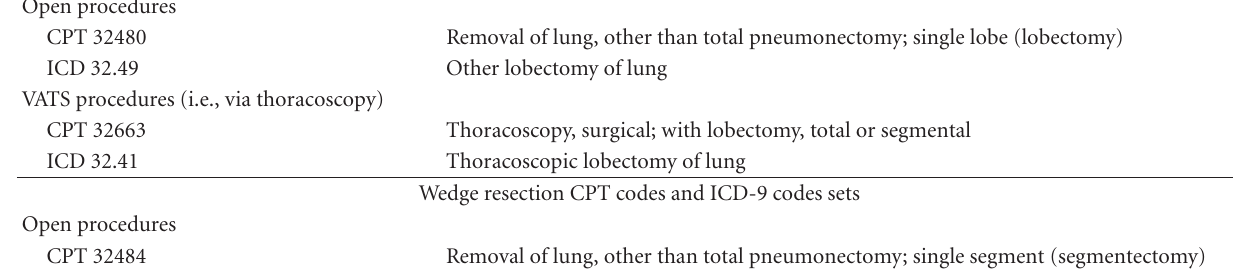
Pulmonary lobectomy CPT codes and ICD-9 codes sets